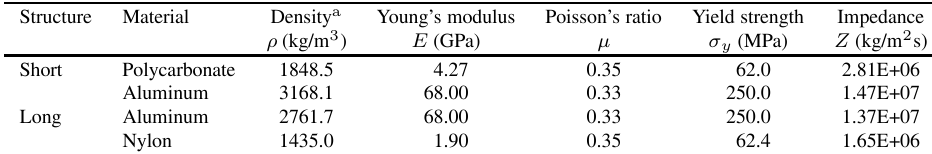
Table 1 Material properties used in the computational study